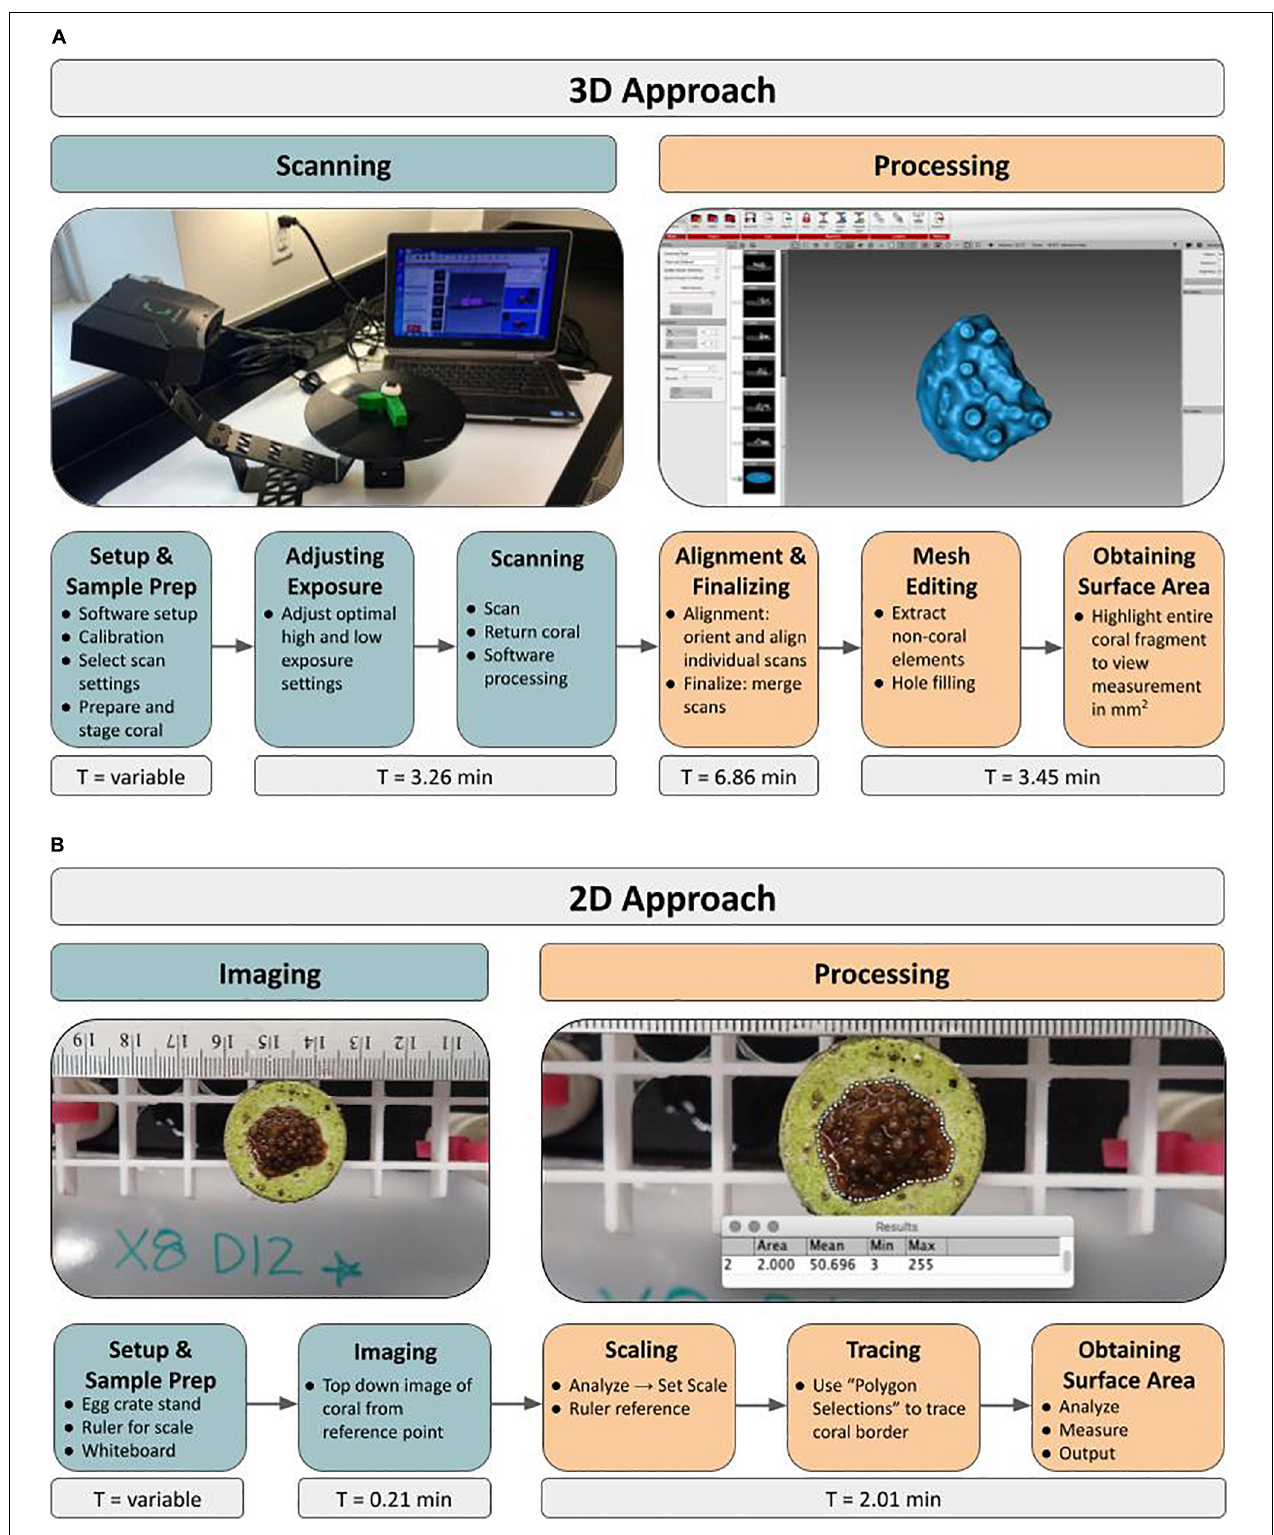
FIGURE 1 | Novel 3D and traditional 2D approaches to quantifying growth rates of live coral microfragments using surface area measurements. Workflow depicts major steps involved in both the 3D scanning approach (A) as well as the 2D photography approach (B) . The initial Setup and Sample Prep time ranges from 0.29 to 0.63 min in the 2D approach and from 4.75 to 6.20 min in the 3D approach.